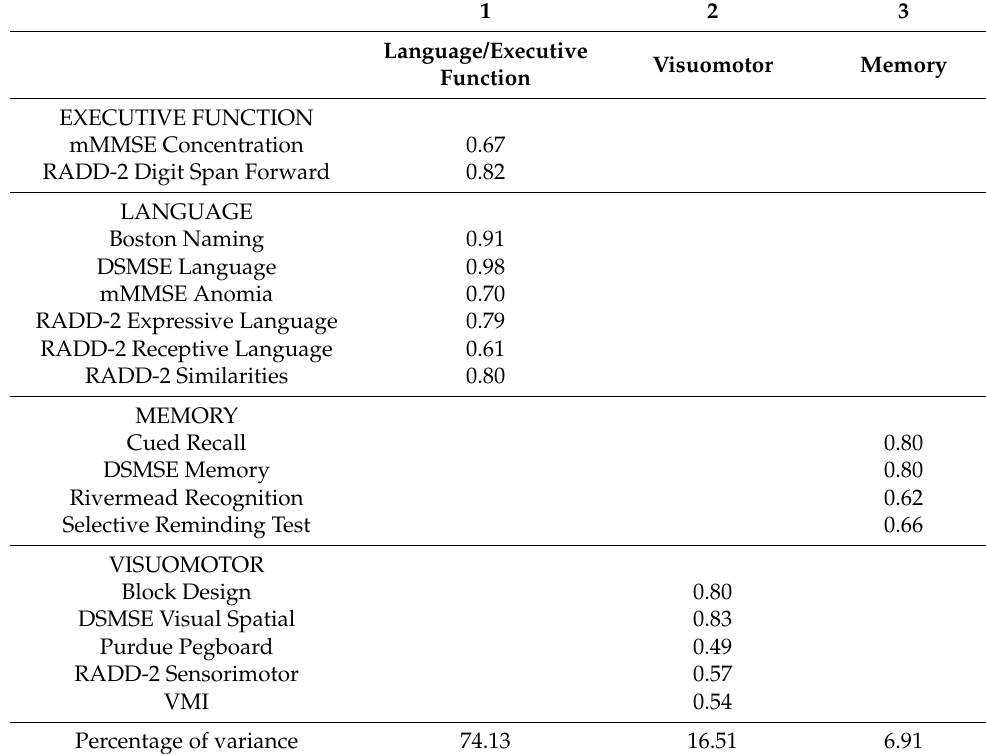
Table 3. Factor structure of the 17 retained cognitive variables across all levels of ID ( n =